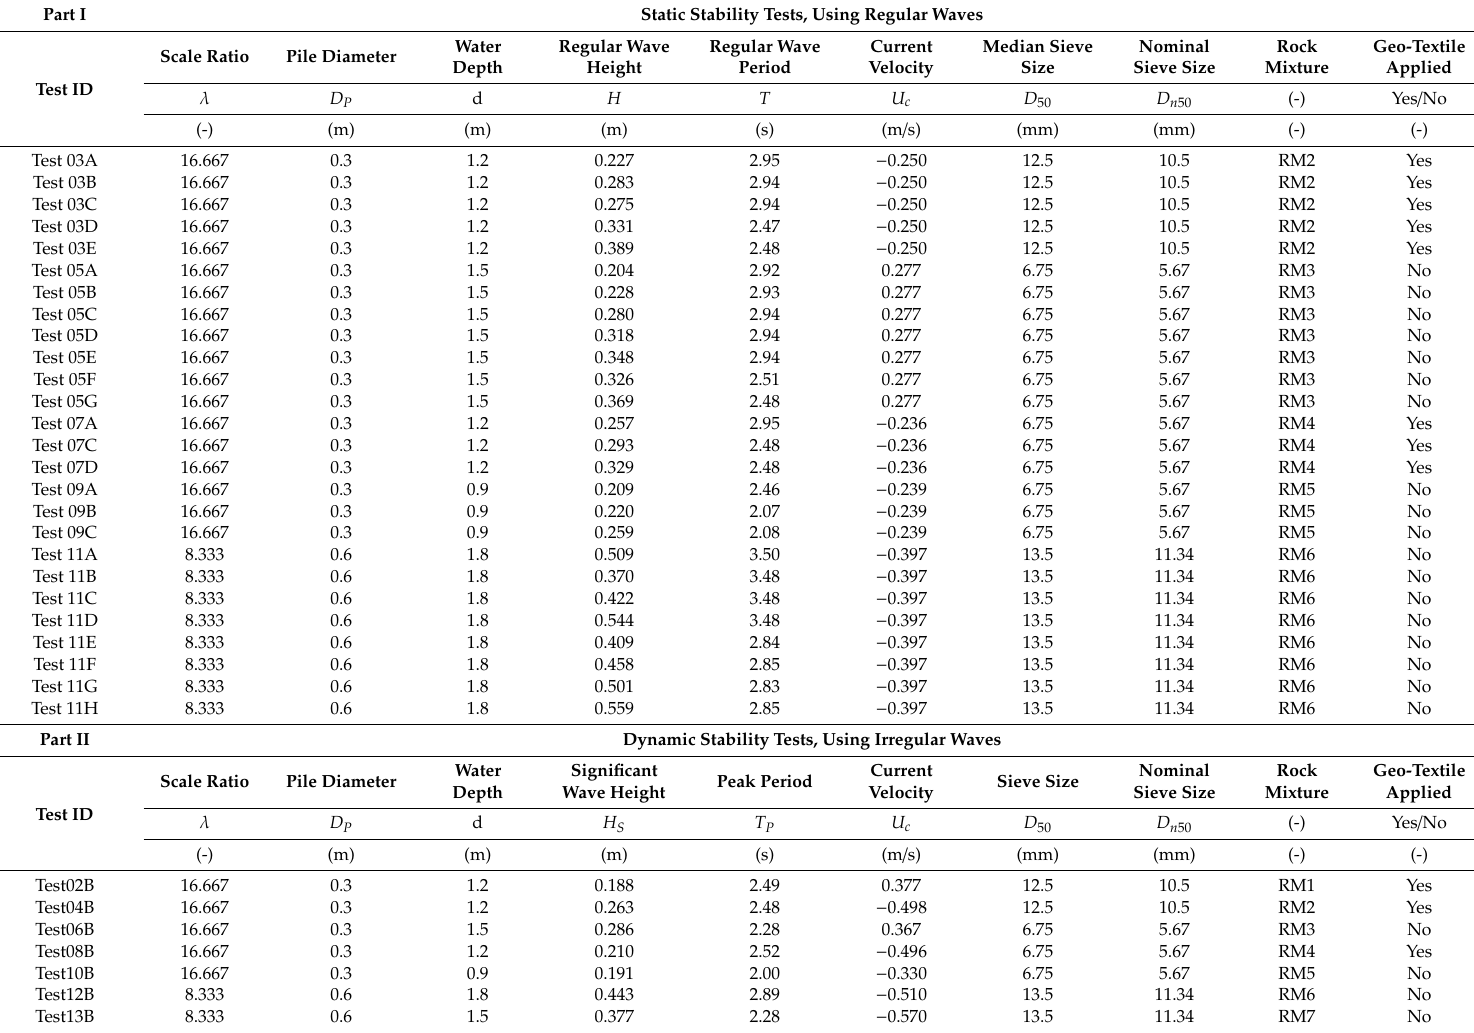
Table 2. Test conditions of large scale experiments of monopile scour